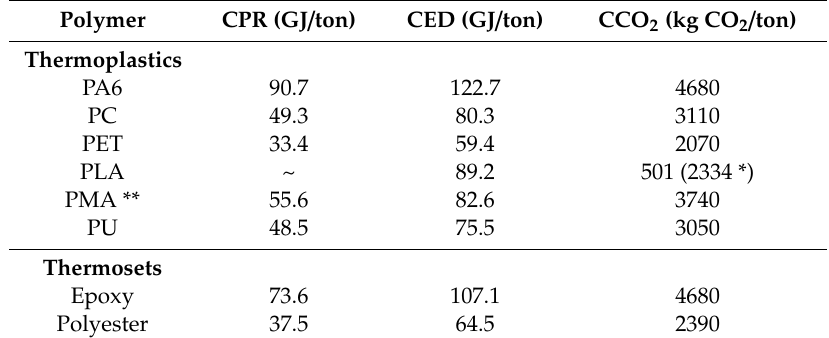
Table 5. Cumulative process energy requirements (CPR), cumulative energy demand (CED) and the related cumulative CO 2 emissions (CCO 2 ) for polymeric products